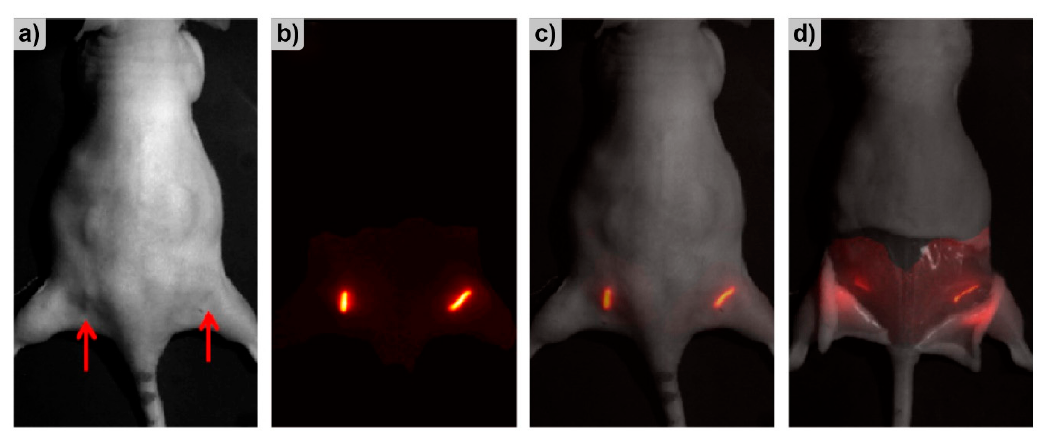
Figure 21. The figure shows ( a ) a white light image of the mouse, ( b ) the normalized fluorescence image, ( c ) an overlay of ( a ) and ( b ) (reference), and ( d ) the residual fluorescence demonstrating continuous diffusion from the spacer over time (image registered after the animal was euthanized and its skin layer and the spacers were removed). Figure adapted with permission from [126].